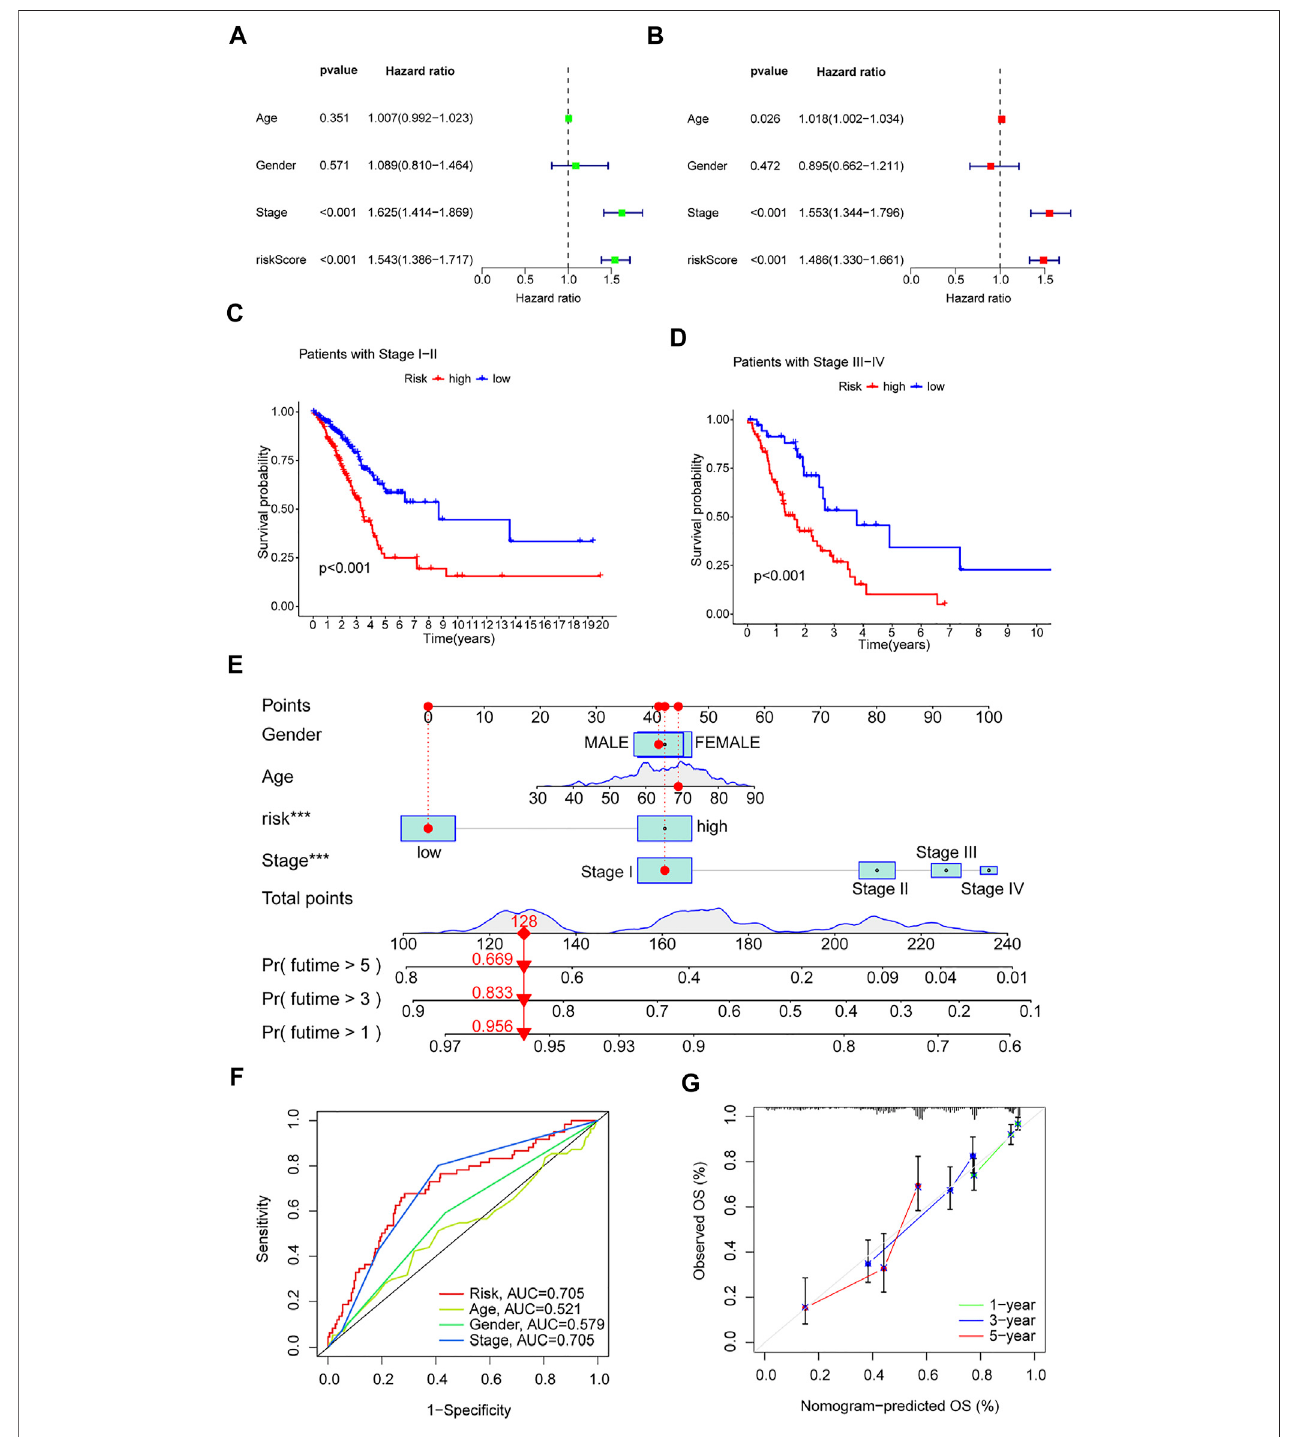
FIGURE 5 | Clinical value of risk characteristics in TCGA-LUAD. (A) Univariate Cox regression analysis of risk scores and clinical factors. (B) Multivariate Cox regression analysis of risk scores and clinical factors. (C,D) Pathological stage was strati fi ed between low- and high-risk groups in the entire collection. (E) Nomogram combining gender,age,stage, and riskscorepredicts1-,3-,and 5-yearsoverallsurvival. (F) Clinicopathologicalfeaturesand thepredictiveaccuracyofriskmodels. (G) Calibration curves test the agreement between actual and predicted results at 1, 3, and 5 years. * p < 0.05, ** p < 0.01, *** p < 0.001.